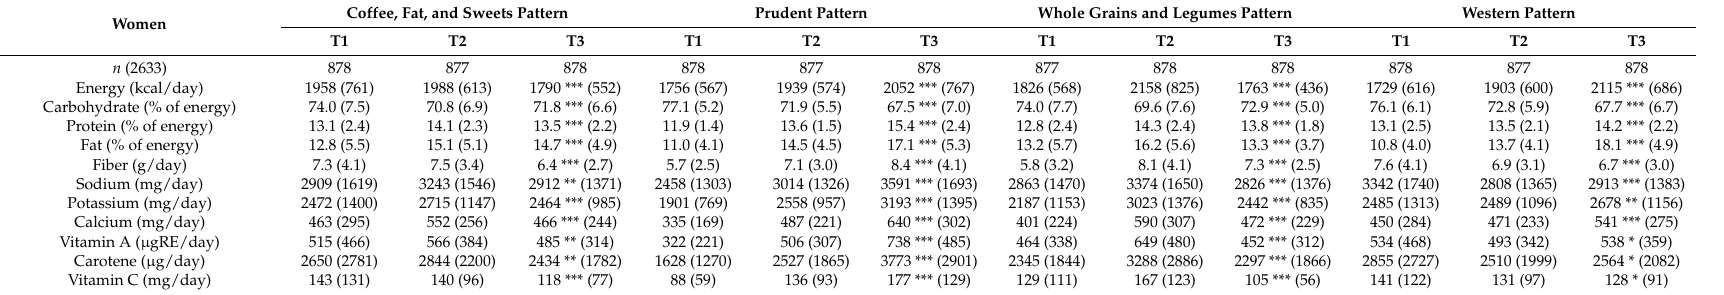
Table 5. Daily nutrient intake of the study participants across the tertiles (T) of dietary pattern scores in women 1,2 . Coffee, Fat, and Sweets Women